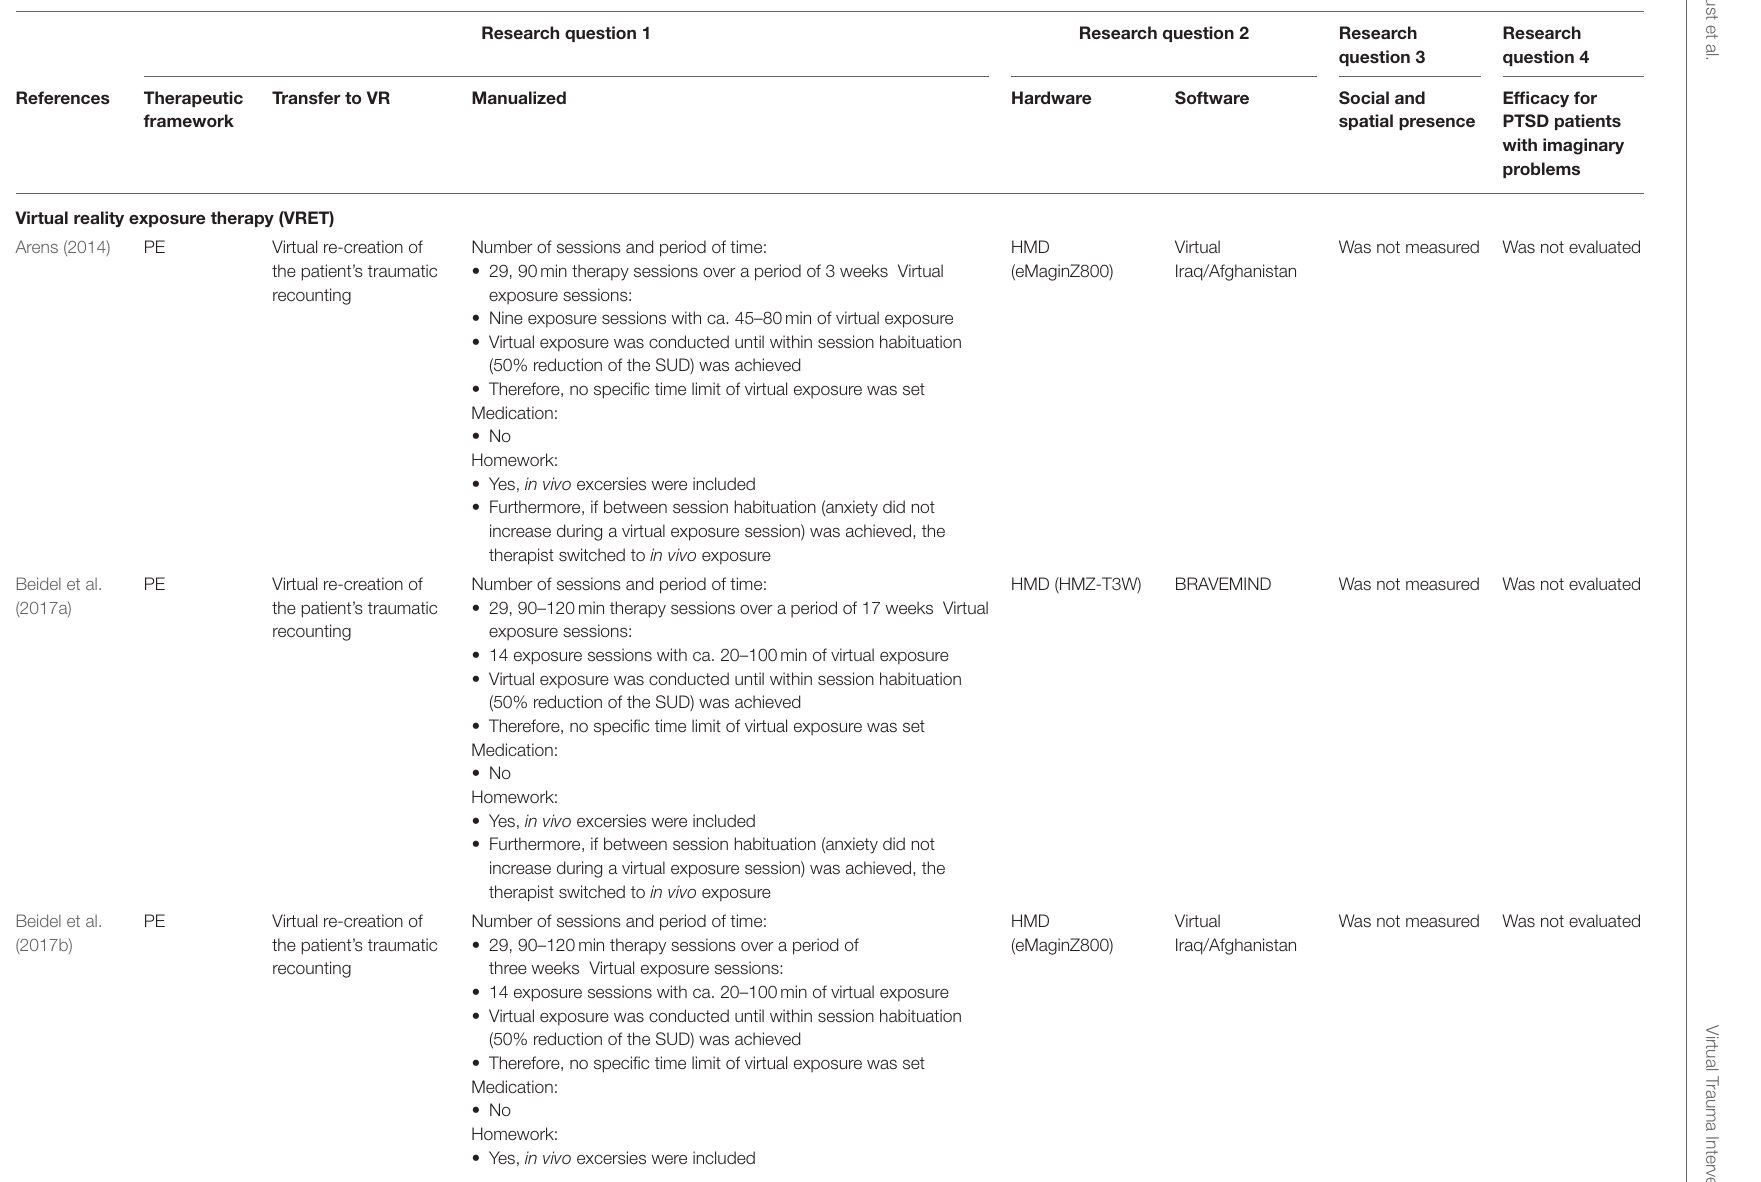
TABLE 2 | Results of the qualitative analysis for each